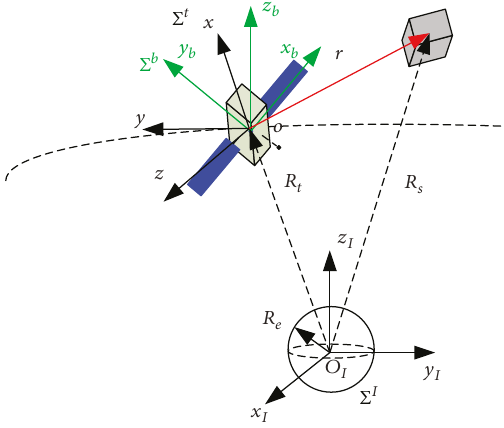
Figure 1: Geometrical relationship and coordinate